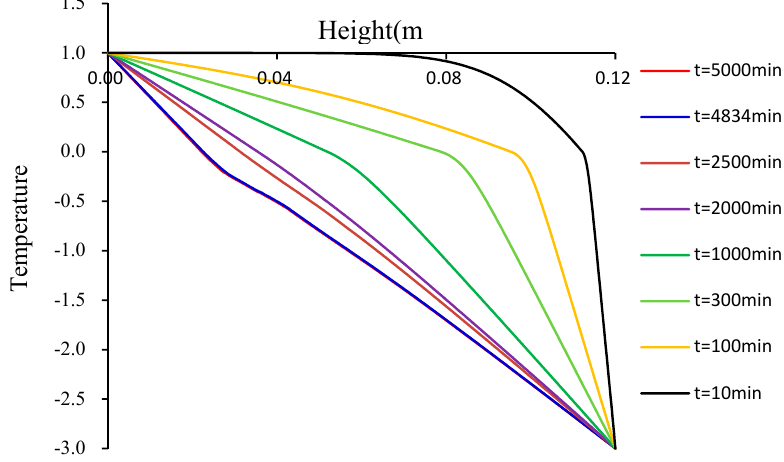
Figure 10. Distribution of void ratio at different durations of freezing.